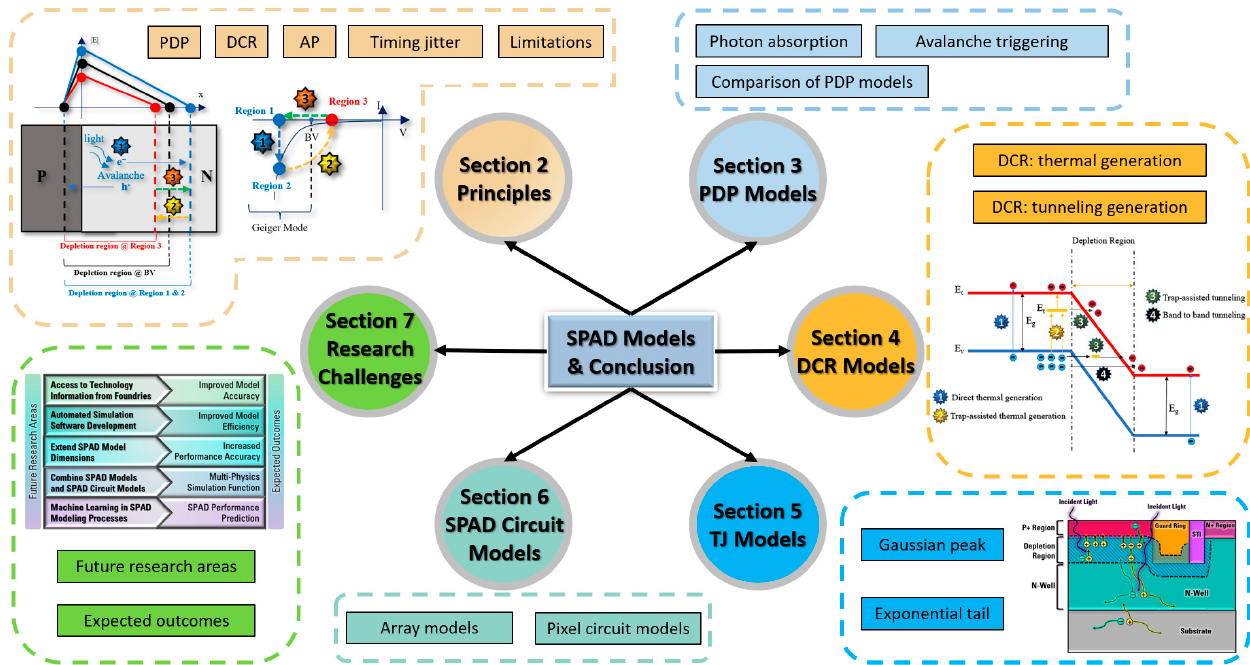
Figure 1. Organization of the SPAD model review paper.